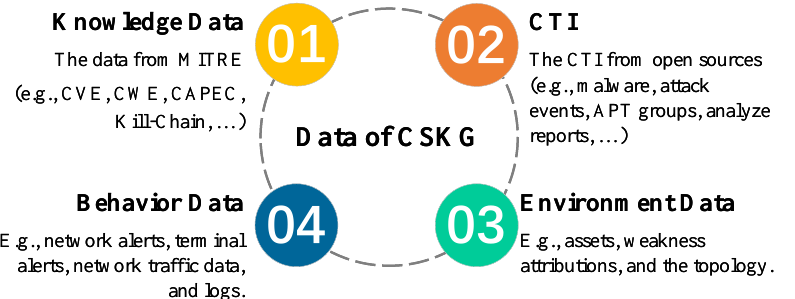
Figure 6. A general experiment network